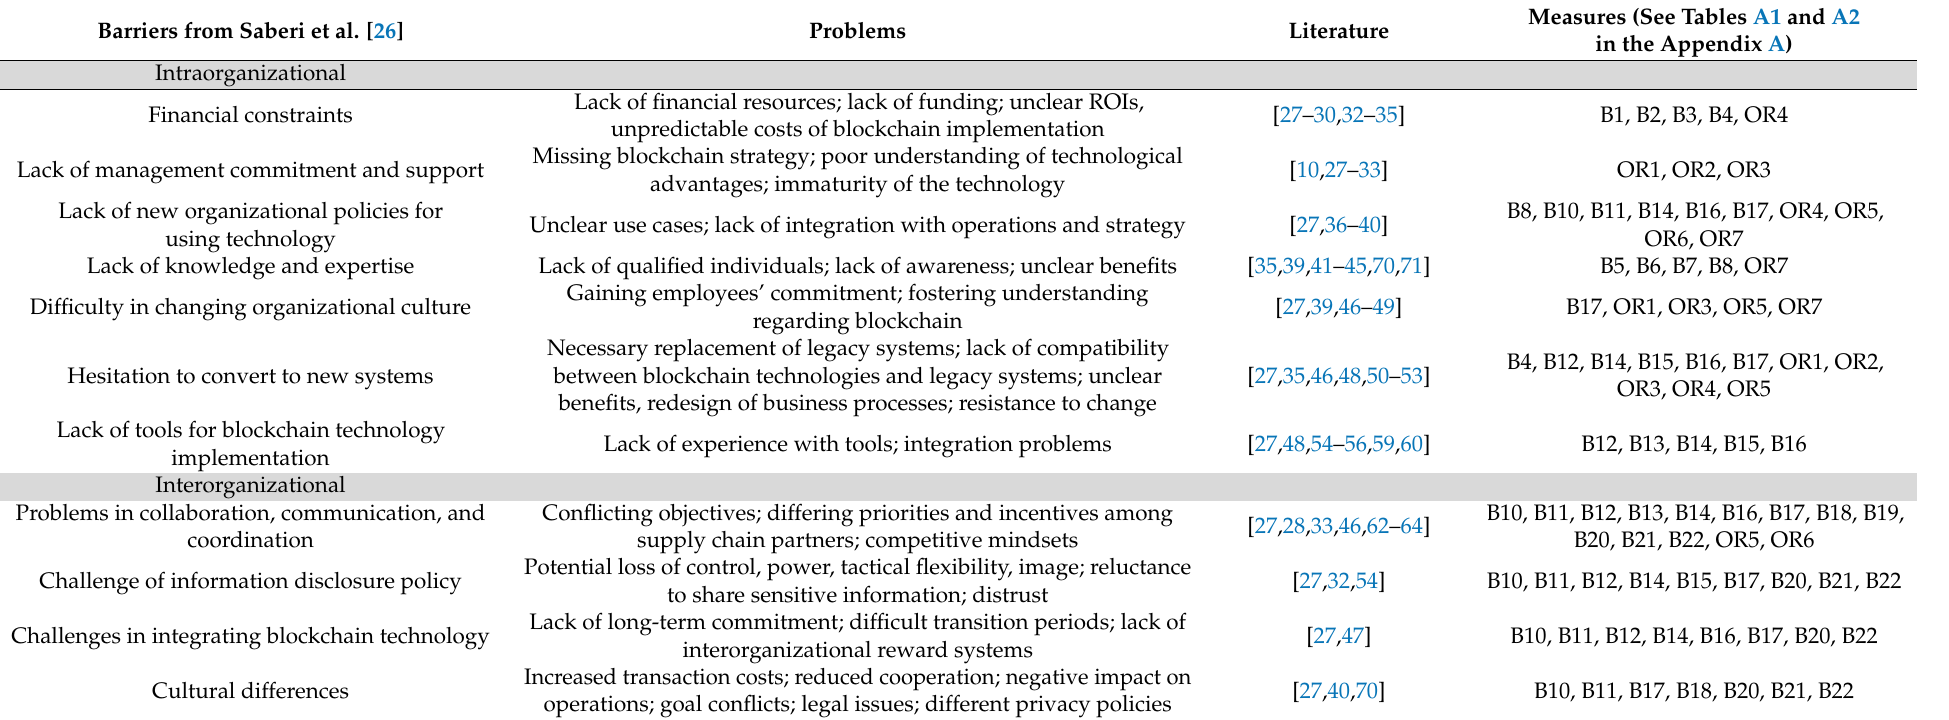
Table 1. Previous research findings and